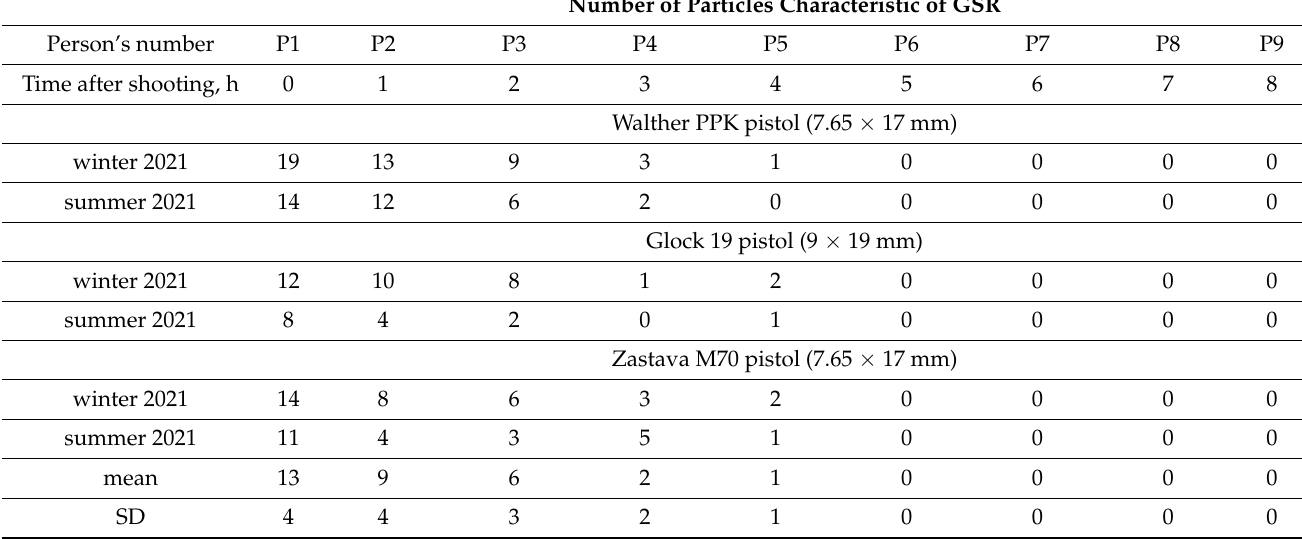
Table 6. Number of particles characteristic of GSR as a function of time after shooting with a low-caliber ammunition. Each person made one shot.